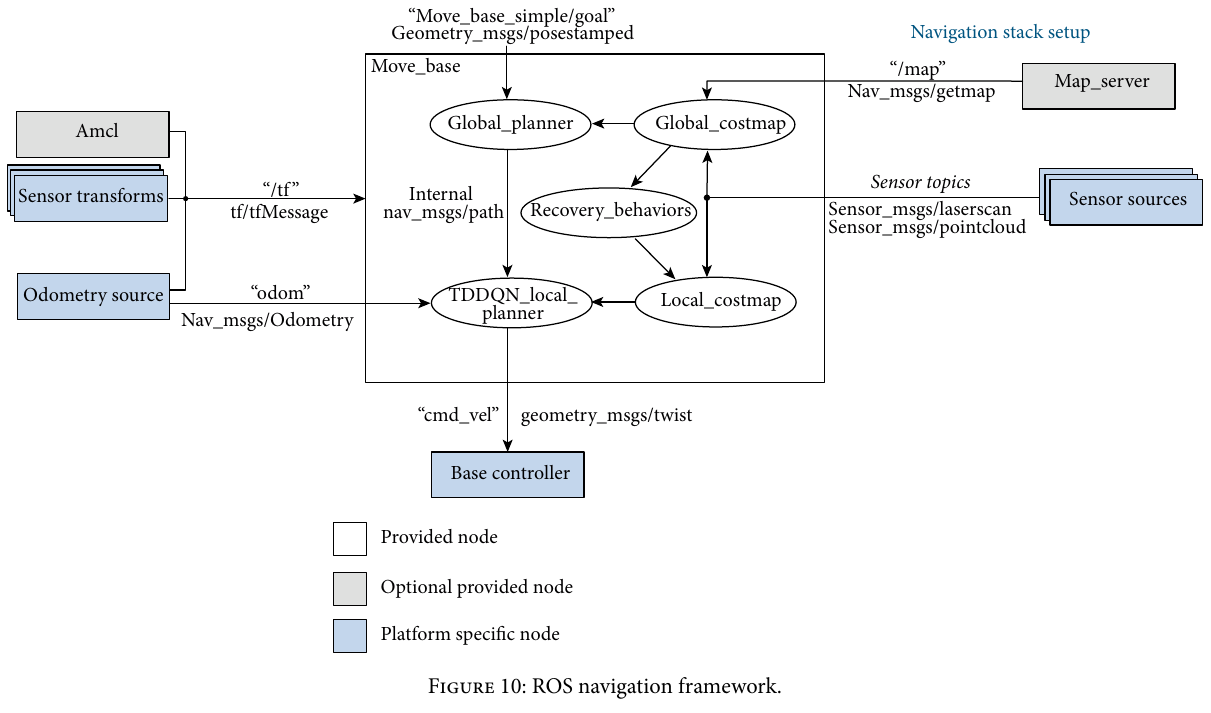
Figure 10: ROS navigation framework.